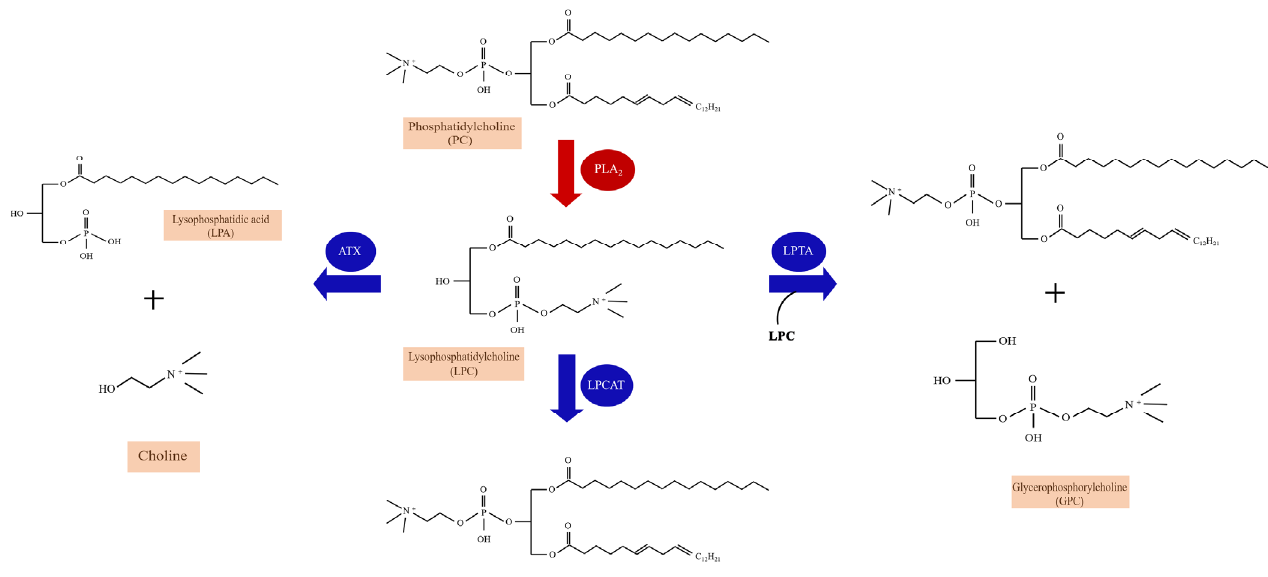
Figure 1. The enzymatic pathways of lysophosphatidylcholine (LPC) synthesis and catabolism. The production of LPC is the result of the fragmentation of the sn-2 residues of phosphatidylcholine (PC) hydrolyzed by PLA2. Three catabolism pathways of LPC are listed. LPC catabolism occurs through a disproportionation reaction involving two LPC molecules catalyzed by cytosolic lysophospholipase-transacylase (LPTA) to form PC and glycerophosphorylcholine (GPC). A hydrolytic pathway is catalyzed by autotaxin (ATX) to yield lysophosphatidic acid (LPA) and choline, and a reacylation pathway to form PC is catalyzed by lysophosphatidylcholine acyltransferase (LPCAT).